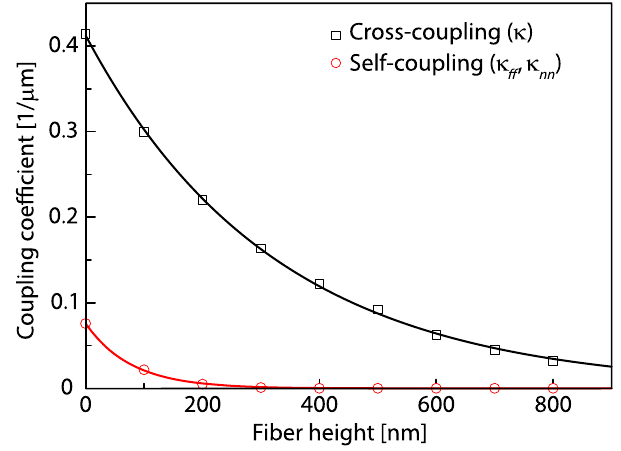
FIG. 8. Waveguide coupling coefficients as a function of fiber taper and nanobeam waveguide separation h . Each data point is obtained by fitting β (cid:2) ð λ Þ with the coupled-mode theory model. Solid lines are single exponential fits to the data